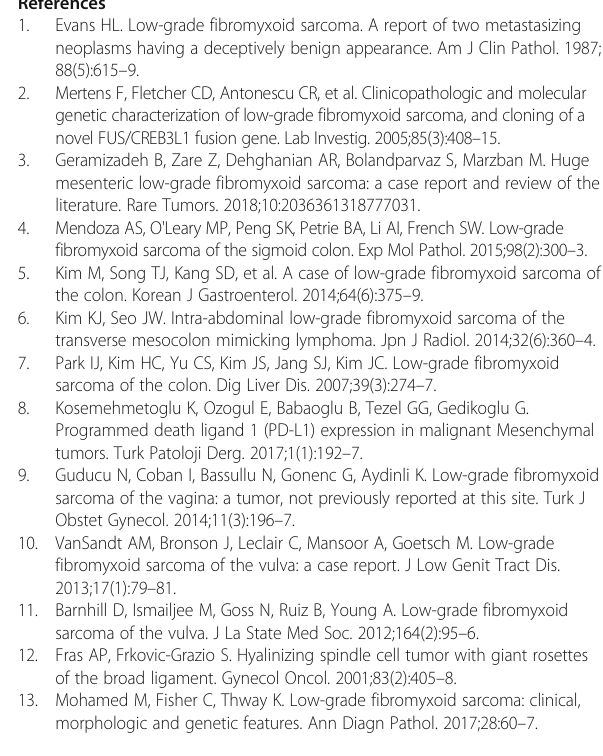
LGFMS: Low-grade fibromyxoid sarcoma; OFMT: Ossifying fibromyxoid tumor; SEF: Sclerosing epithelioid